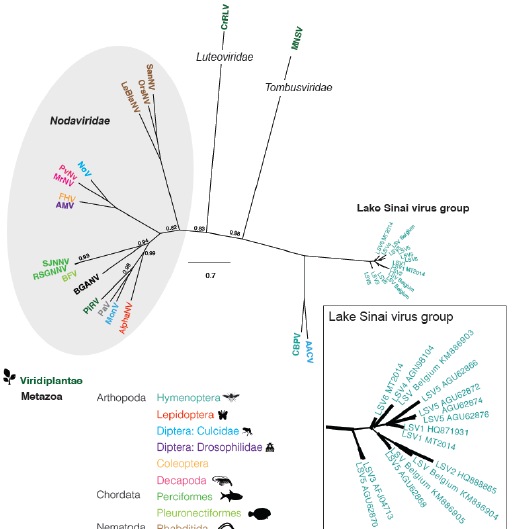
Figure 3. Lake Sinai virus phylogenetic relationship inferred from RdRp amino acid sequences. Majority rule Bayesian consensus tree of Lake Sinai viruses derived from Bayesian analysis of an RNA dependent RNA polymerase (RdRp) amino acid alignment implemented in MrBayes v3.1.2 using the WAG amino acid substitution model (Supplementary Figure S6) [39]. Numbers on branches are Bayesian posterior